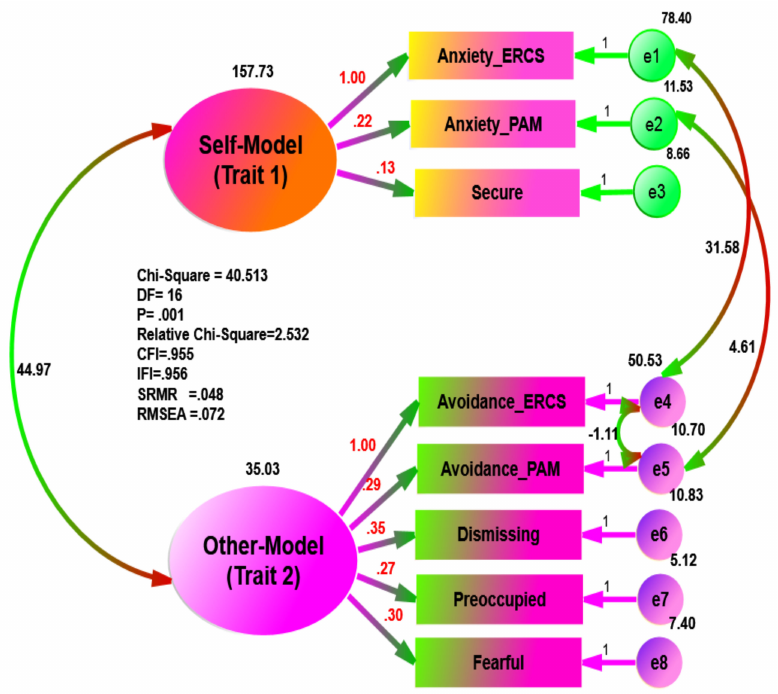
Figure 6. Multi-Traits of Hypothesized Measurement Models of the Attachment Theory in Non- Psychiatric